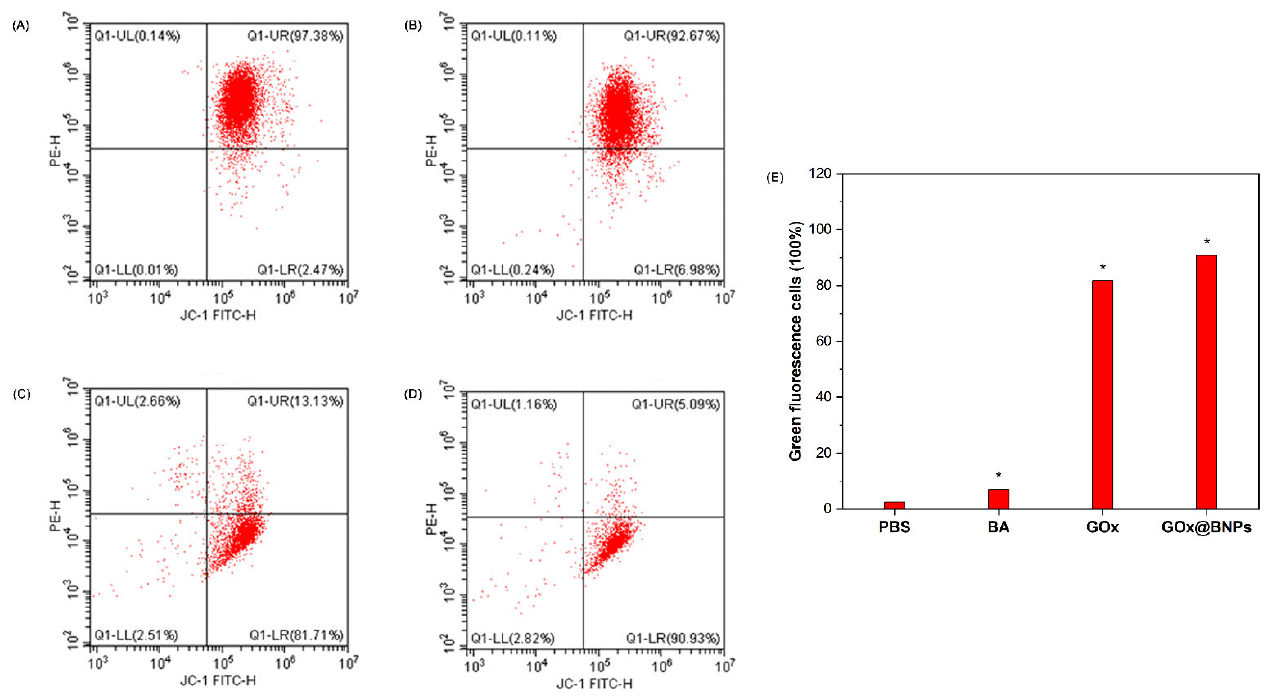
Figure 8. Representative flow cytometric analysis of JC-1-stained A549 cells treated with ( A ) PBS; ( B ) BA; ( C ) GOx; and ( D ) GOx@BNPs. ( E ) Statistical analysis of A549 cells treated with different groups (* p < 0.05). A549 cells were treated with different groups for 24 h, and then incubated with JC-1 at 37 ◦ C for 15 min and, finally, detected via flow cytometry. The decrease in MTP is indicated by an increase in the percentage of green fluorescence cells.